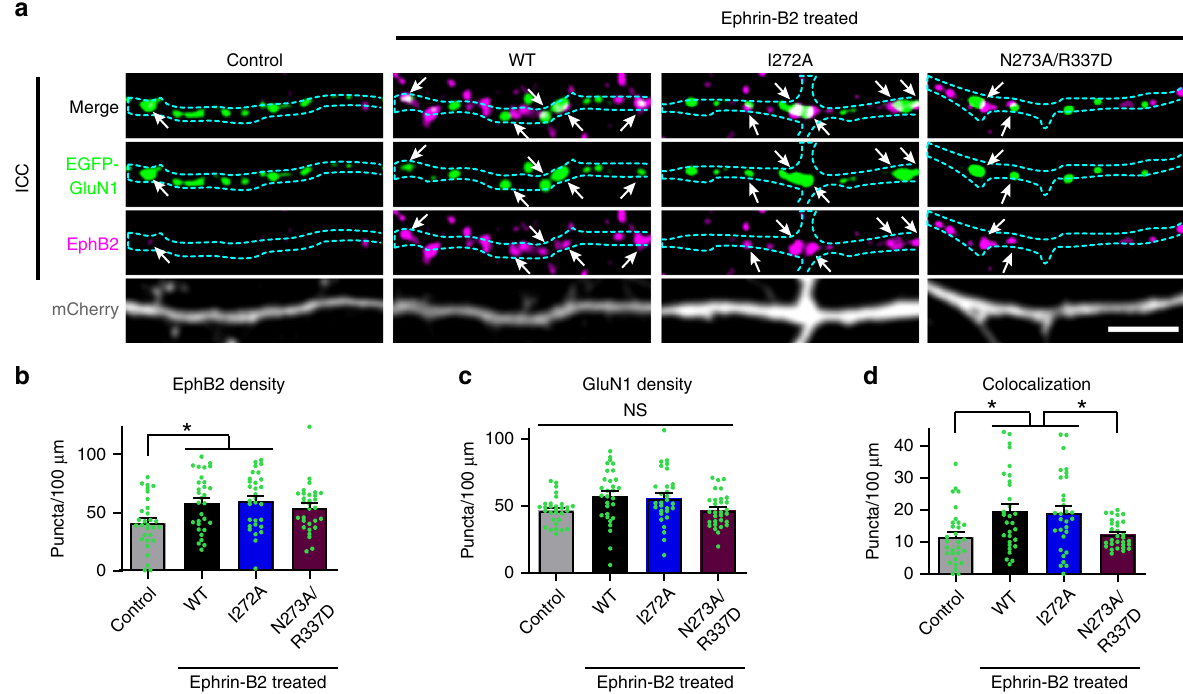
Fig. 7 GluN1 charge mutants show disrupted EphB – NMDAR interaction in neurons. a Representative images of dendrites of DIV6-9 cortical neurons transfected with EGFP – GluN1 (WT, I272A, or N273A/R337D), mCherry, GluN2B, and CRISPR constructs to knock out endogenous GluN1. The control condition is WT GluN1-transfected treated with control reagents instead of ephrin-B2. The other three conditions were treated with ephrin-B2 for 45 min to induce the interaction between the NMDAR and EphBs. Top row panels show the colocalization between EGFP – GluN1 and EphB2 in white (arrows indicate examples of colocalized puncta). Second row panels show the high contrasted images of EGFP – GluN1 in green. Third row panels show endogenous EphB2 in magenta. Last row panels show mCherry. Outlines of morphology in cyan. Scale bar = 5 µ m. b Quanti fi cation of EphB2 density (puncta number per 100 µ m) in indicated groups (* p < 0.05, ANOVA; green dots represent n = 30 cells for each condition). c Quanti fi cation of EGFP – GluN1 density (puncta number per 100 µ m) in indicated groups ( p = 0.0128, ANOVA followed by Tukey ’ s; comparisons showed no signi fi cant differences; green dots represent n = 30 cells for each condition). d Quanti fi cation of the effects of the different GluN1 mutants on colocalization (puncta number per 100 µ m) between GluN1 and EphB2 (* p < 0.05, ANOVA; green dots represent n = 30 cells for each